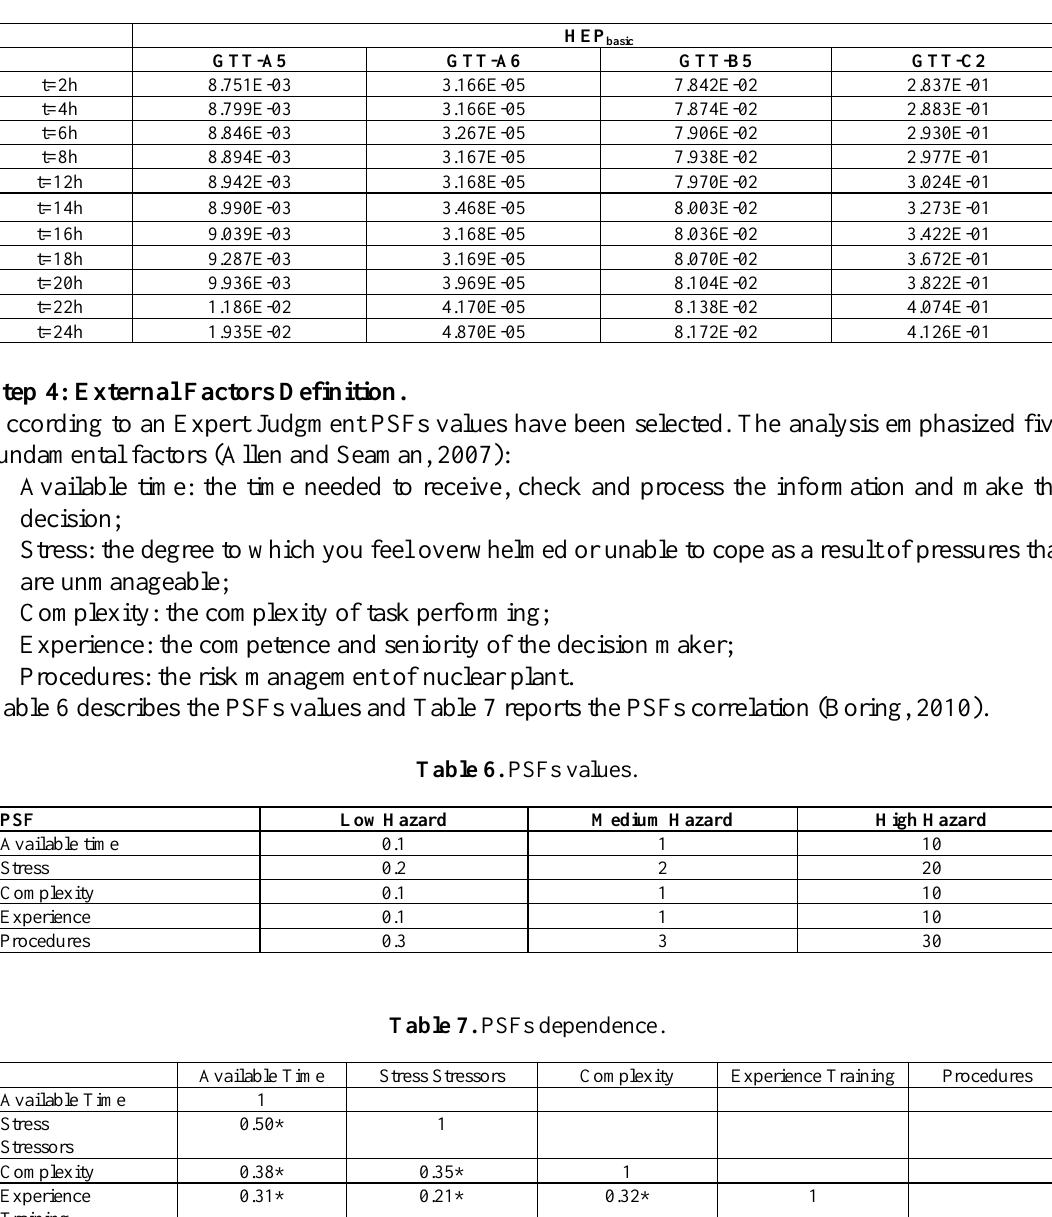
Table 5. HEP basic .